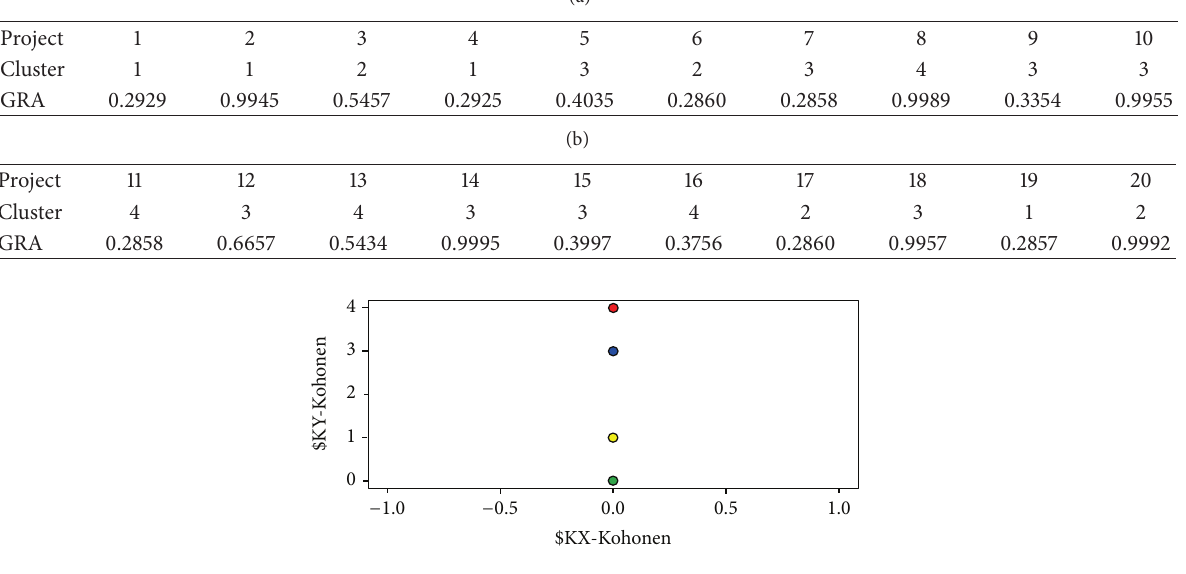
Figure 6: The results from implementation of the neural network.